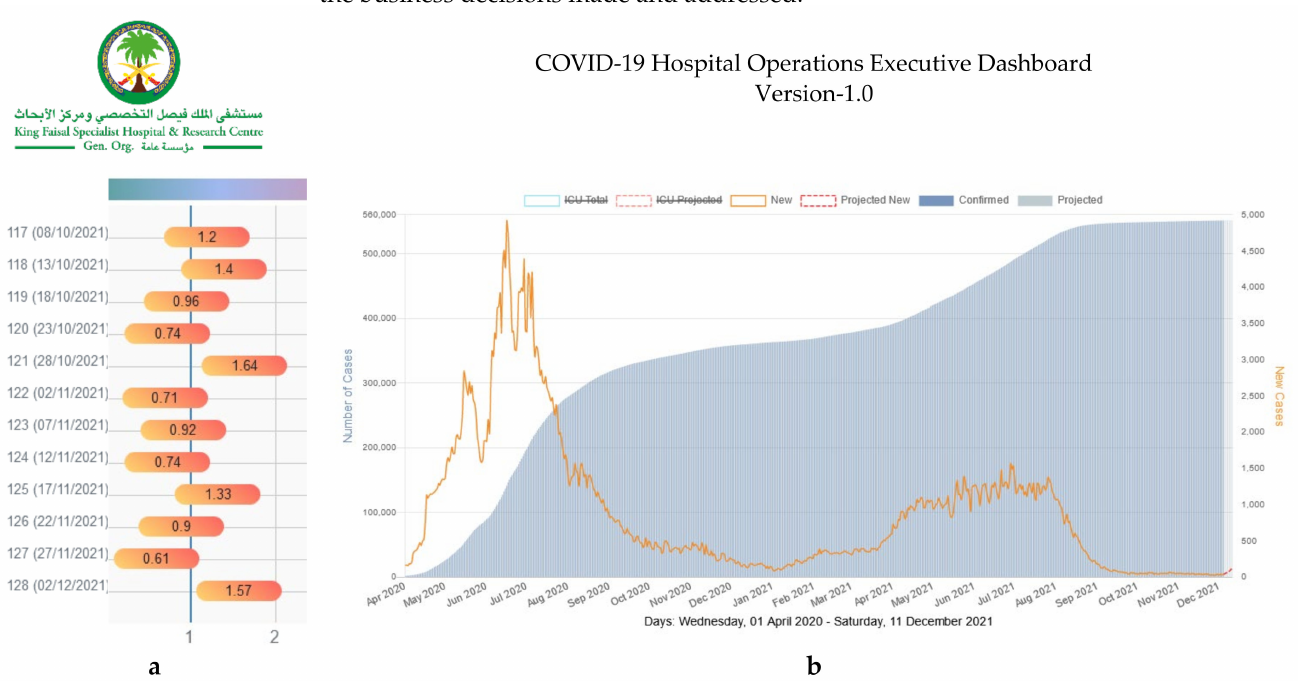
Figure 1. ( a ) National Effective R-value (5-day incubation period). ( b ) National Current and Projected COVID-19 Cases (5-day moving